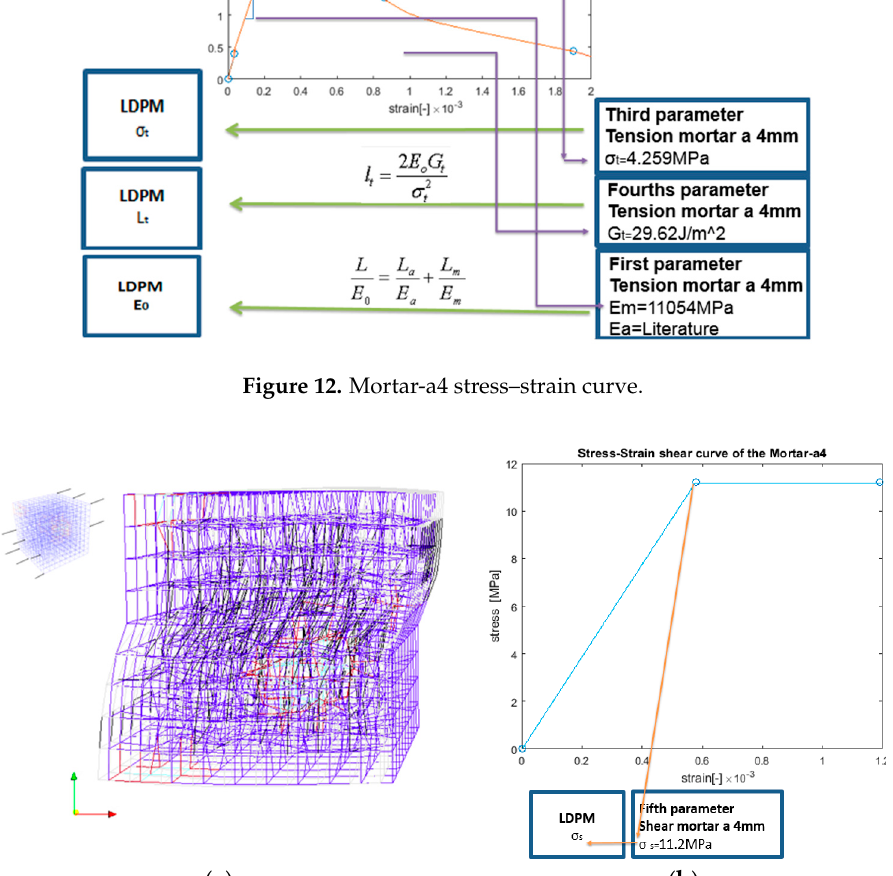
Figure 12. Mortar-a4 stress–strain curve.